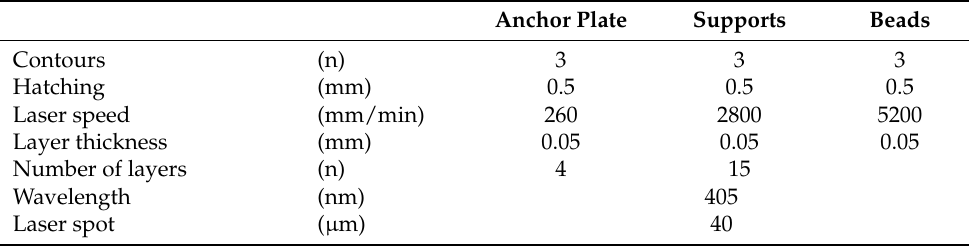
Table 3. Process parameters used for the beads produced by vat photopolymerization. Anchor Plate Supports Beads